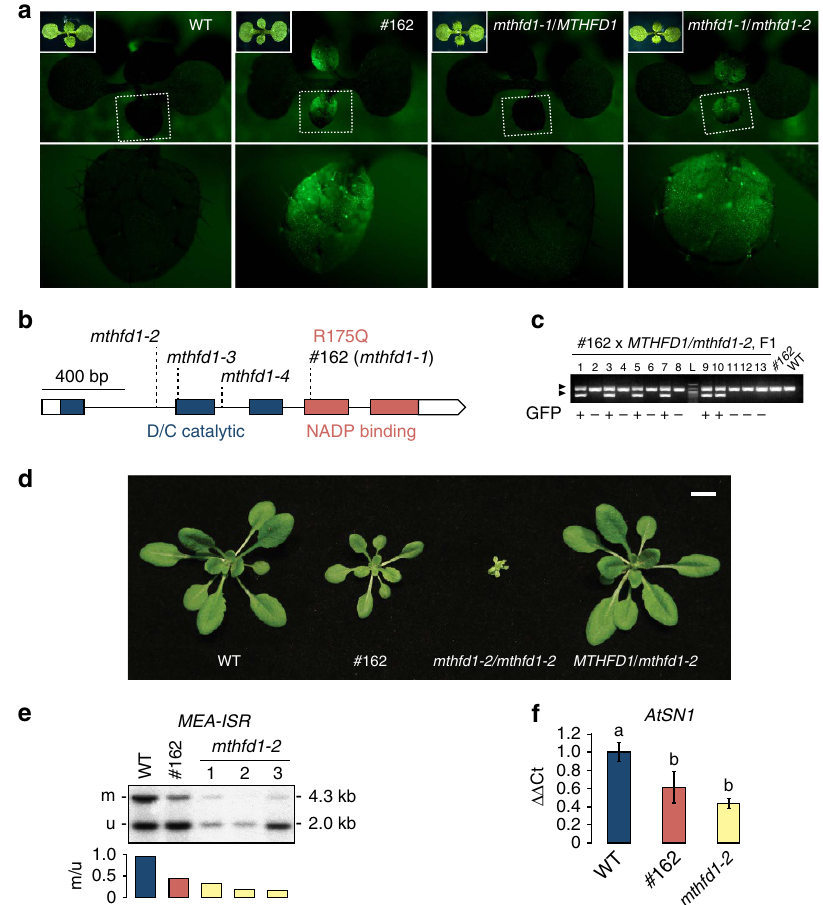
Figure 1 | SDCpro-GFP expression and DNA demethylation caused by R175Q mutation in MTHFD1 . ( a ) GFP fluorescence micrographs of WT, #162 M2, MTHFD1/ mthfd1-2 F1 and #162/ mthfd1-2 F1 seedlings. F1 are progeny of #162 M2 x MTHFD1/mthfd1-2 . Dashed boxes indicate magnified areas shown in lower panels. Inlets show bright-field images. ( b ) Gene structure, positions of mutations and conserved domains of MTHFD1. The EMS mutation in #162 lead to a R175Q substitution of a conserved residue required for NADP binding 28 . ( c ) PCR-based genotype analysis of 13 F1 seedlings and two control samples. Arrowheads mark bands corresponding to WT/ mthfd1-1 (upper) and mthfd1-2 (lower). The mthfd1-2 allele co-segregates with GFP fluorescence in F1 ( þ : present, (cid:2) : absent). L, ladder. ( d ) Habit of different genotype plants 20 days after germination. Scale bar, 10mm. ( e ) DNA blot analysis of non-CG